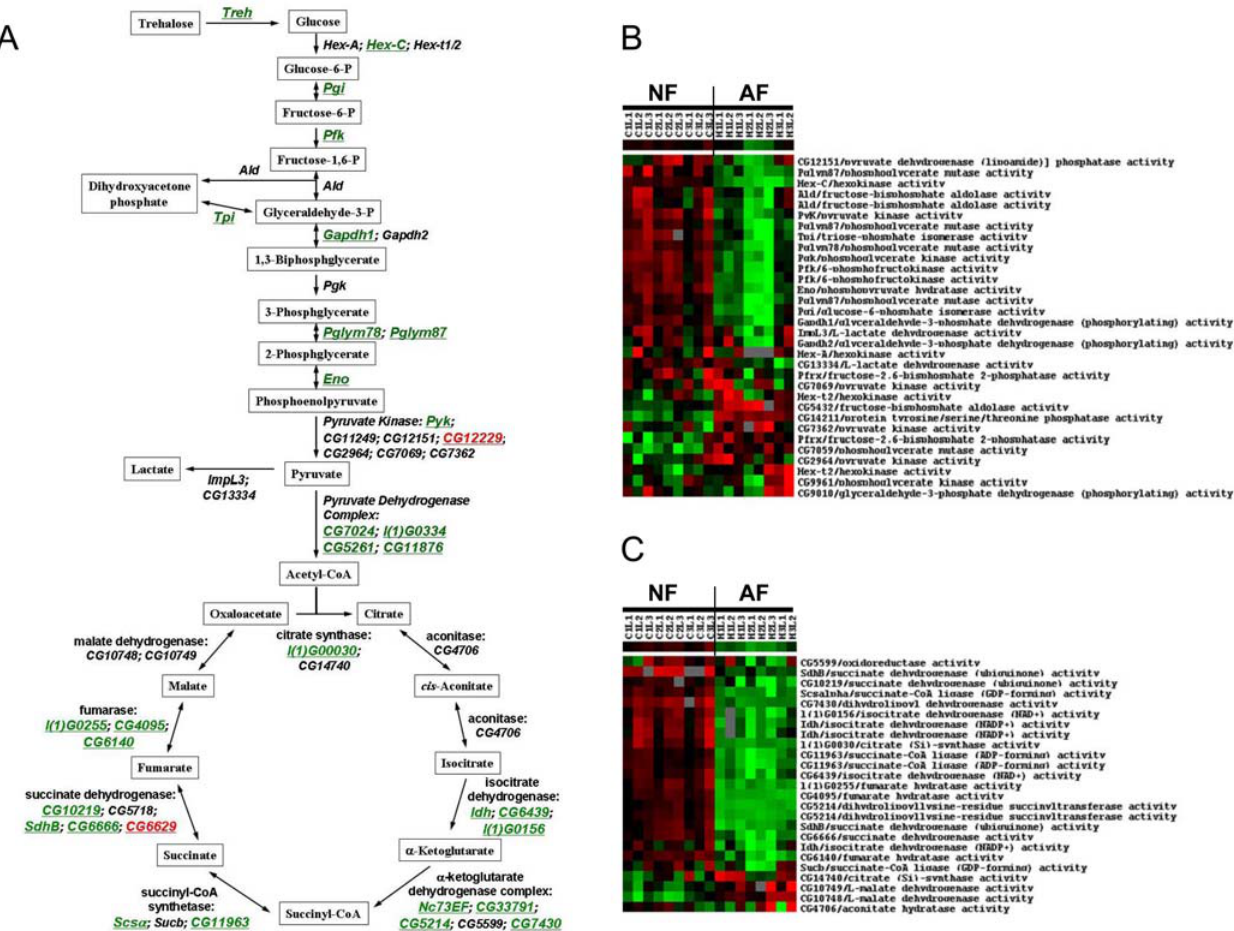
Figure 4. Suppression of genes encoding glycolytic and TCA cycle enzymes. A) Schematic illustration of the alterations in genes encoding glycolytic and TCA cycle enzymes (green: down-regulation, black: not significantly changed, red: up-regulation). B) Cluster map of changes in genes encoding glycolytic enzymes in NF and AF larvae. C) Cluster map of changes in genes encoding TCA cycle enzymes in NF and AF larvae. Each cluster contained 9 hybridizations of NF and 8 hybridizations of AF samples.